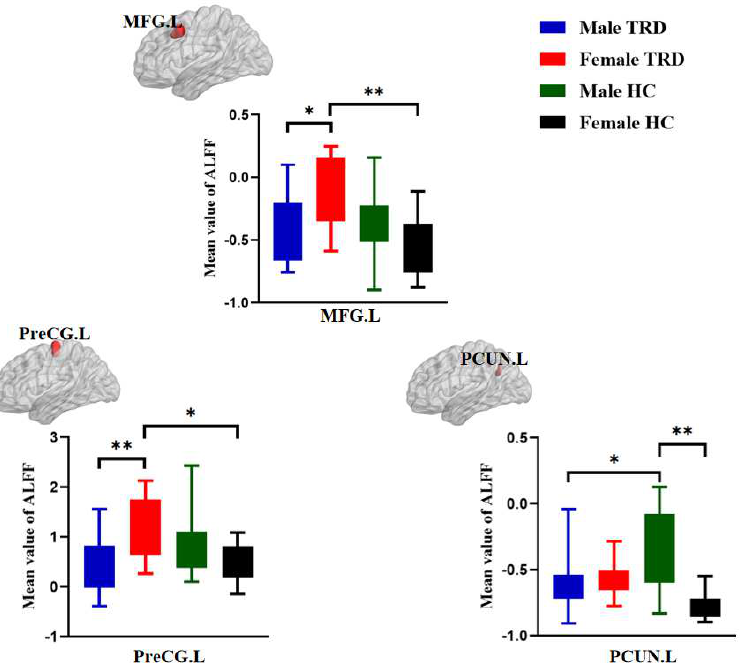
Figure 2. Post hoc analyses in ALFF among the four groups. MFG.L, Left middle frontal gyrus; PreCG.L, left precentral gyrus; PCUN.L, Left precuneus; ** p < 0.001, * p < 0.0125.